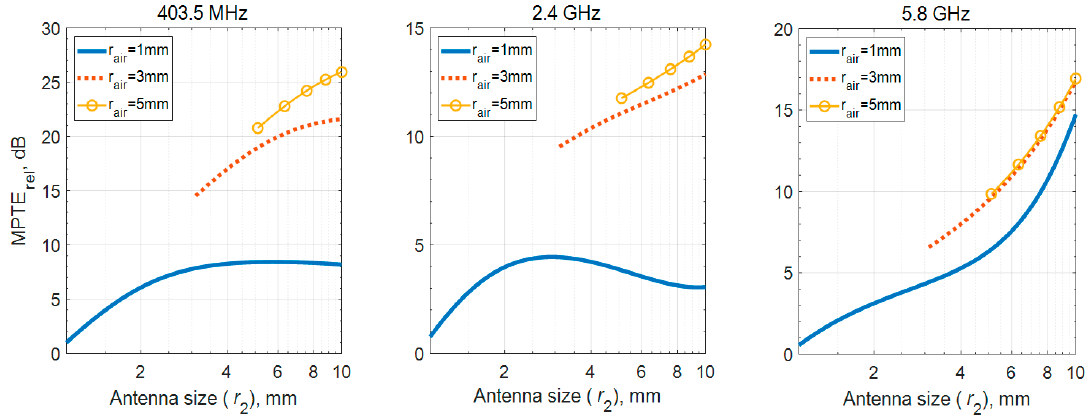
Figure 7. MPTE rel results according to antenna size adjusted by air region.